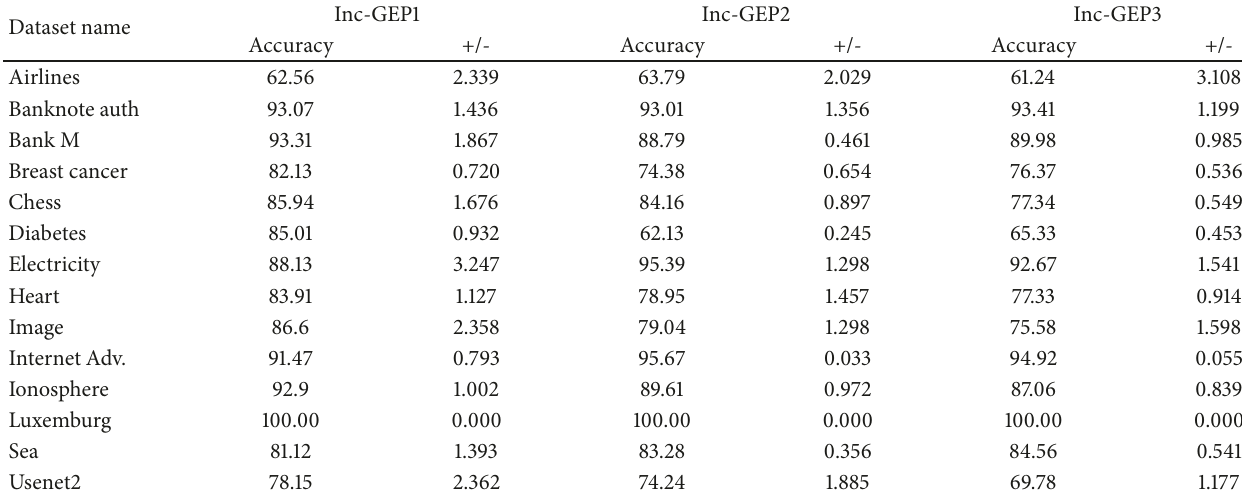
Table 3: Computational experiment results (mean accuracy and standard deviation,